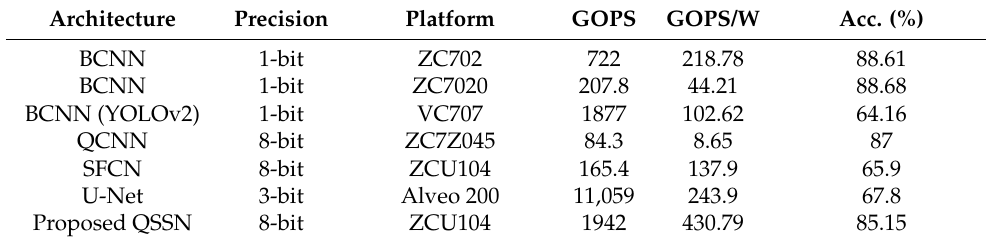
Table 4. Performance Comparison of Quantized Neural